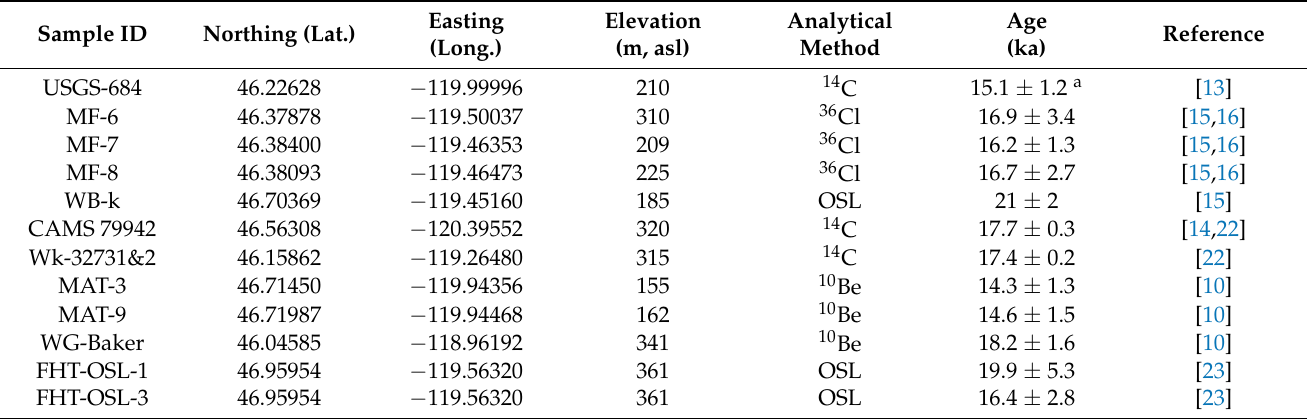
Figure 3. Extent of hydraulically ponded flood waters of Lake Lewis, assuming a flood stage of 380 m asl and a schematic outline at a flood stage of 366 m asl (dashed) [16,17], showing the locations of available numerical ages. Table 1. Existing chronological data for Lake Lewis.